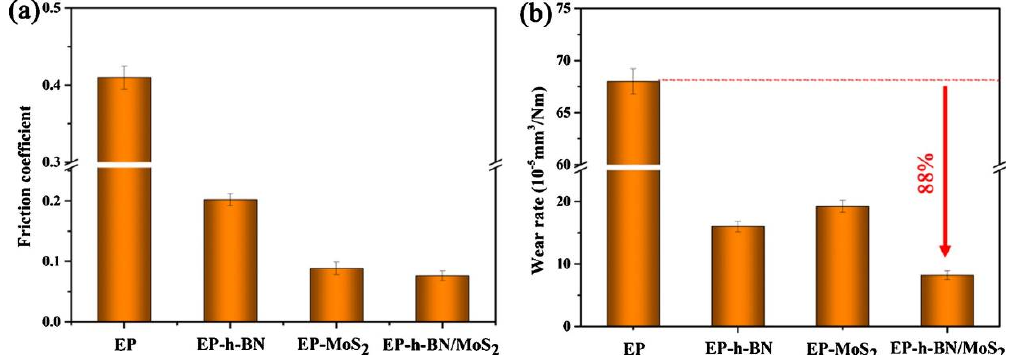
Figure 10. ( a ) Coefficient of friction and ( b ) wear rate of EP, EP-h-BN, EP-MoS 2 and EP-h-BN/MoS 2 composite coatings sliding against 440c ball under dry friction (EP = epoxy). Reproduced with permission from [102]. Copyright 2010 Elsevier.